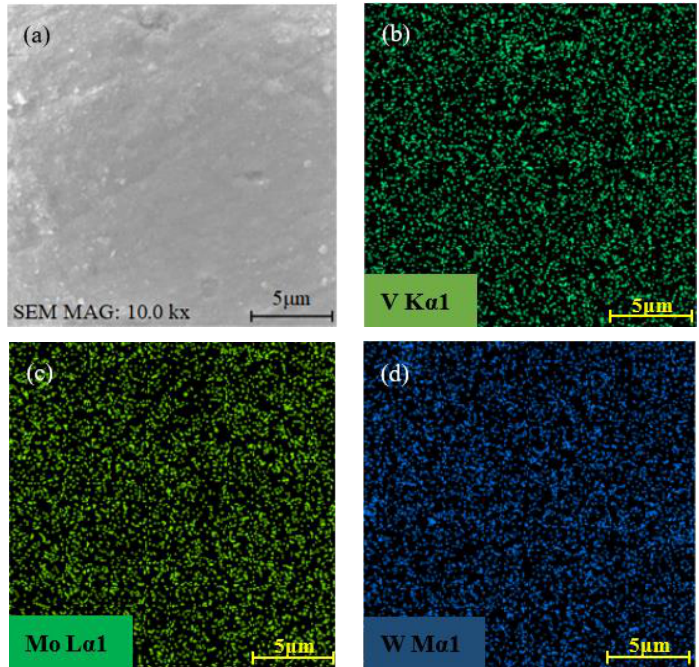
Figure 5. Morphology of the V 1.6 Mo 1.7 W 1.8 /TiO 2 before reaction. ( a ) SEM image, 10.0 kx; ( b ) EDS image V element dispersion; ( c ) EDS image Mo element dispersion; ( d ) EDS image W element dispersion.